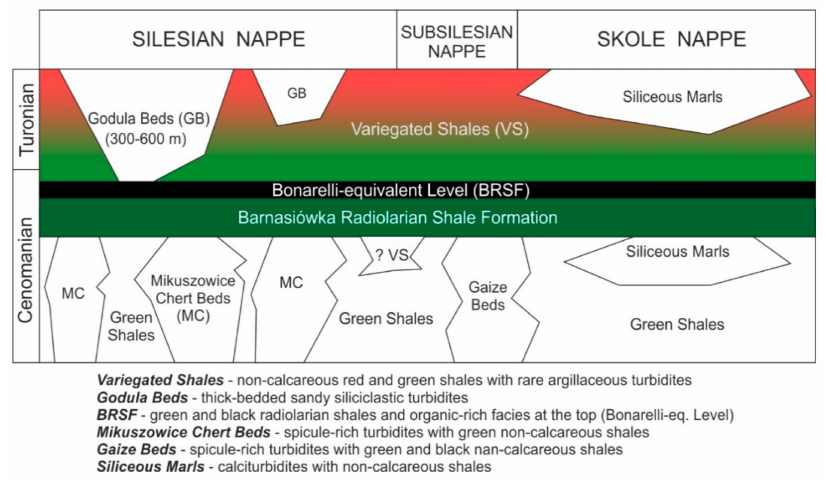
Figure 2. Lithostratigraphy of the Cenomanian–Turonian deposits in the Polish Outer Carpathians (after [33,36–39] supplemented by the authors).